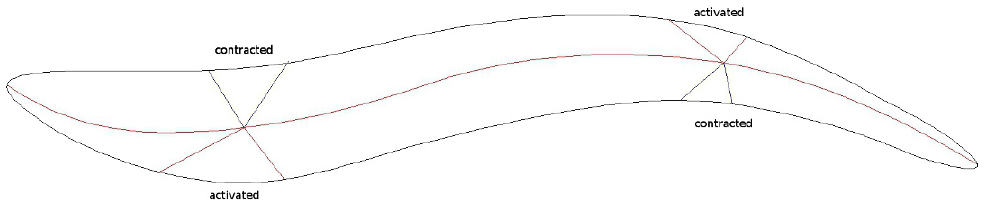
Figure 4. Operation of a fish-like airship using dielectric elastomer